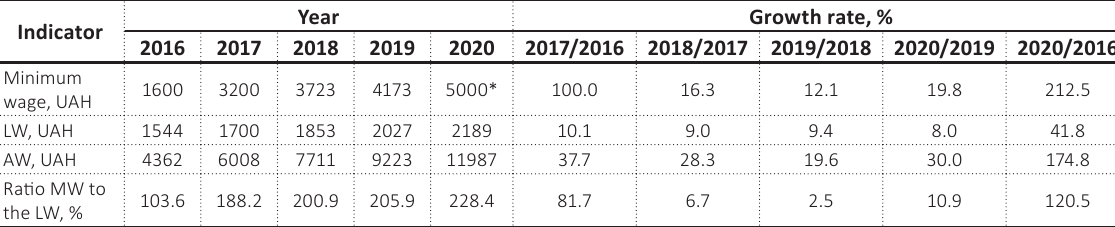
Table 1. Dynamics of the main indicators of living standards in Ukraine